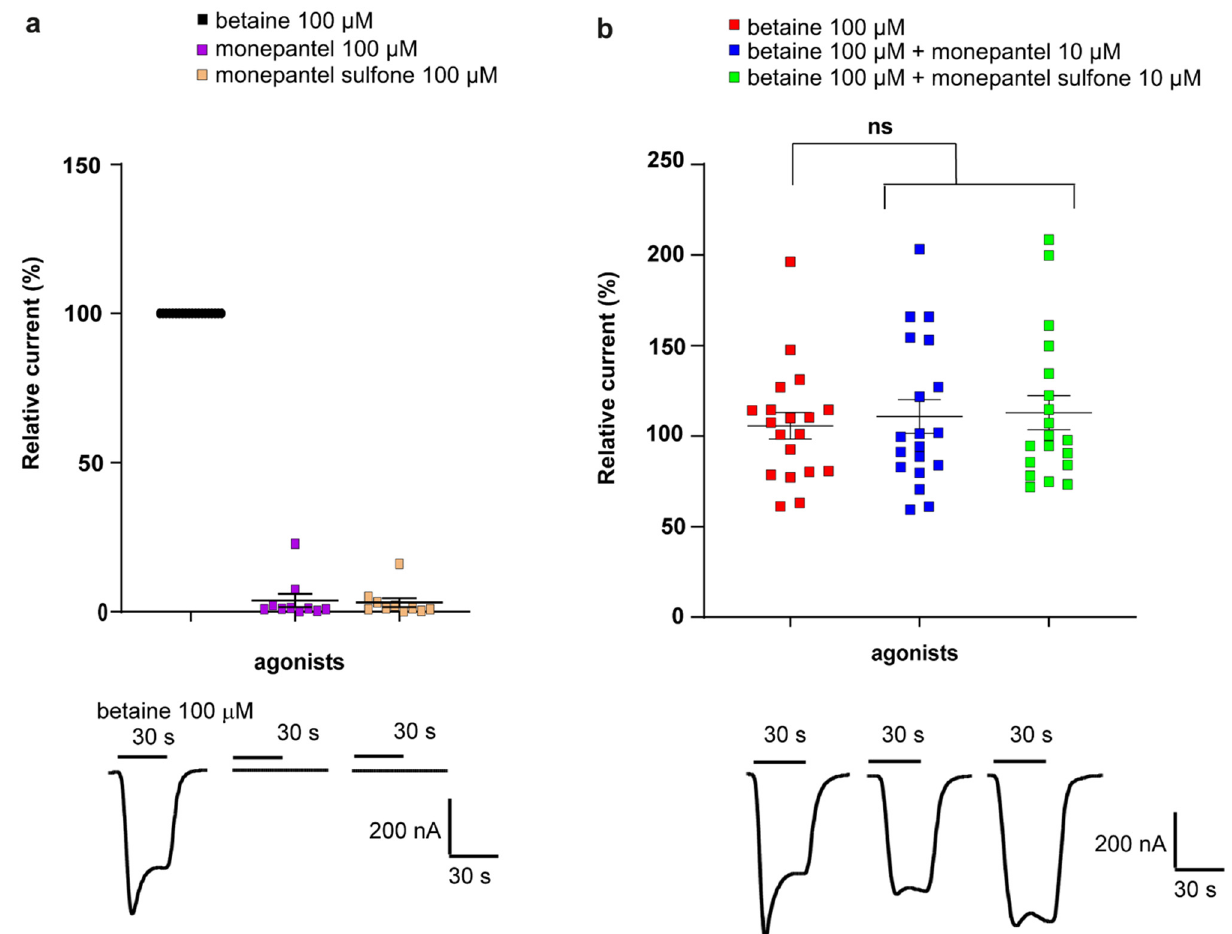
Figure 3. Effect of monepantel and monepantel sulfone on the Cel- DEG-3/DES-2 channel. Scatter dot plots (mean ± SEM) and representative traces show the efficacy of monepantel and monepantel sulfone used as direct agonists ( n = 10) ( a ) and as allosteric modulators in co-application with betaine ( n = 19) ( b ). The perfusion time was 30 s as indicated with short bars above the traces.